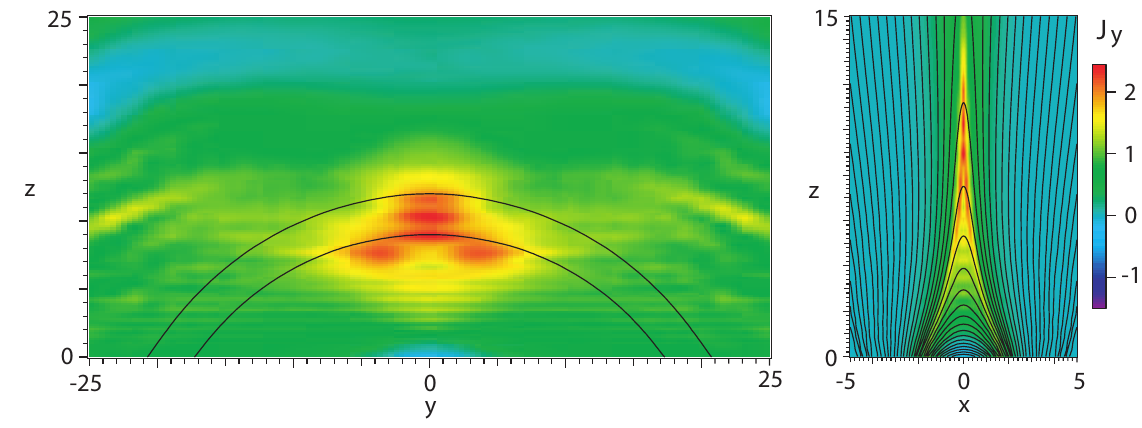
Fig. 2. (a) Current density J y and magnetic field lines in the y,z plane and (b) current density J y and magnetic field in the x,z plane for the force-free case after completion of the footpoint motion.